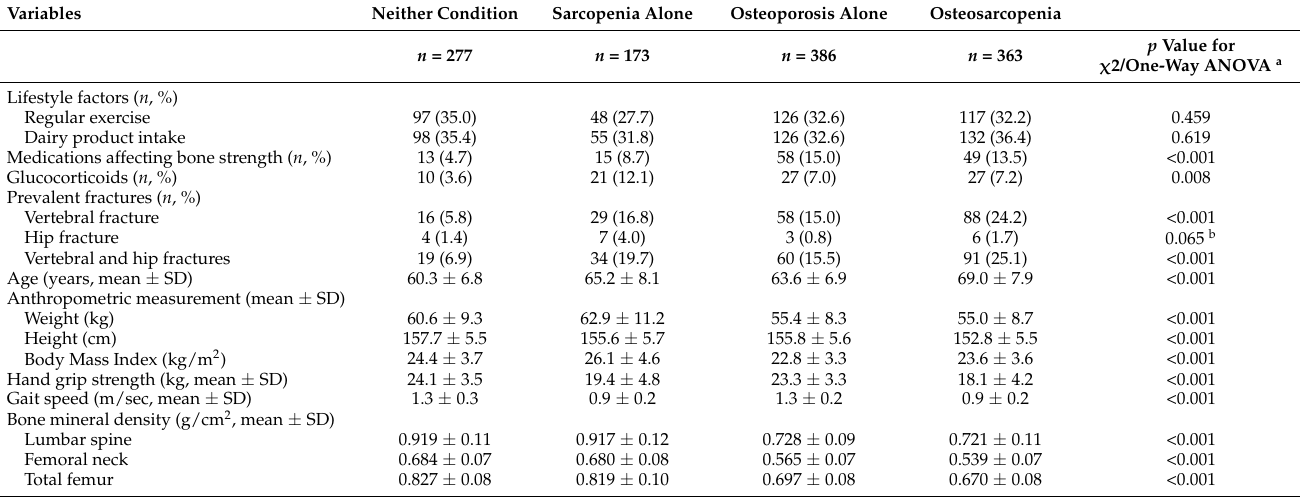
p Value for χ 2/One-Way ANOVA a